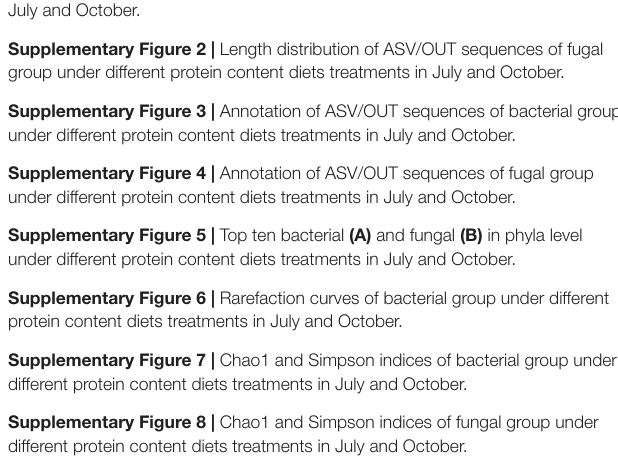
Supplementary Figure 1 | Length distribution of ASV/OUT sequences of bacterial group under different protein content diets treatments in July and October. Supplementary Figure 2 | Length distribution of ASV/OUT sequences of fugal group under different protein content diets treatments in July and October. Supplementary Figure 3 | Annotation of ASV/OUT sequences of bacterial group under different protein content diets treatments in July and October. Supplementary Figure 4 | Annotation of ASV/OUT sequences of fugal group under different protein content diets treatments in July and October. Supplementary Figure 5 | Top ten bacterial (A) and fungal (B) in phyla level under different protein content diets treatments in July and October. Supplementary Figure 6 | Rarefaction curves of bacterial group under different protein content diets treatments in July and October. Supplementary Figure 7 | Chao1 and Simpson indices of bacterial group under different protein content diets treatments in July and October. Supplementary Figure 8 | Chao1 and Simpson indices of fungal group under different protein content diets treatments in July and